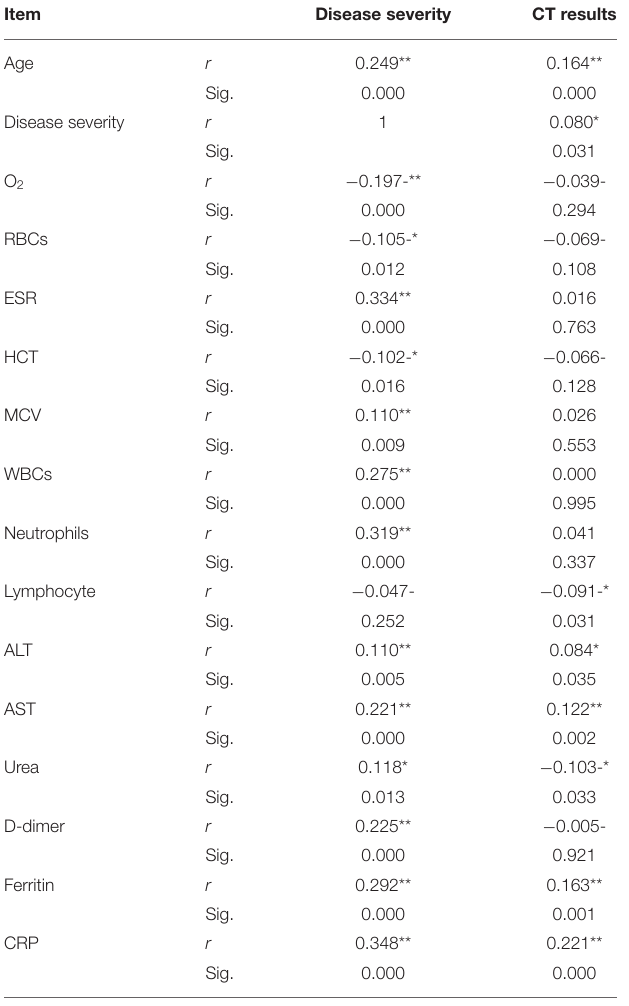
TABLE 5 | Correlation between clinical, laboratory, disease severity and CT findings. Item